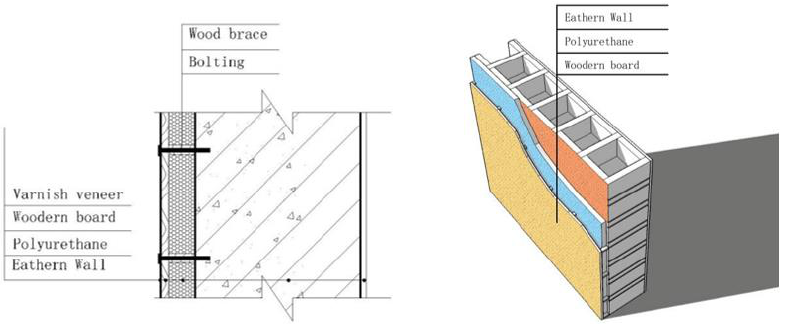
Figure 6. Exterior wall renewal method.